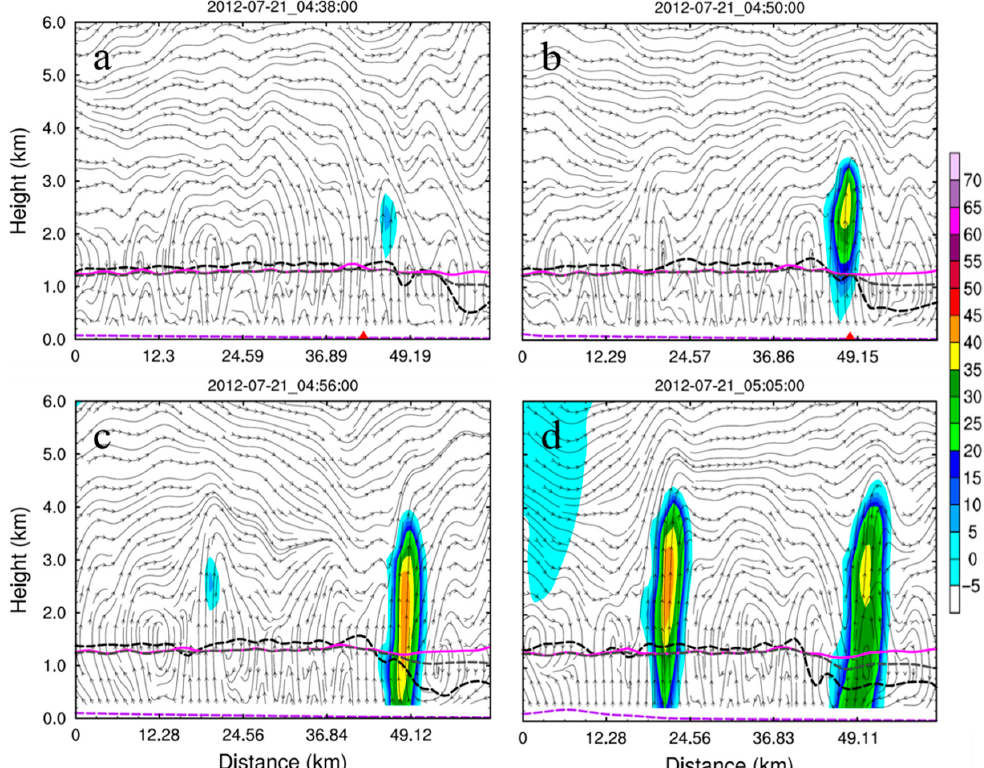
Figure 7. ( a – d ) Vertical cross sections of the simulated composite radar reflectivity (shaded, units: dBZ), the wind field (streamlines, units: m s − 1 ), the lifting condensation level (LCL) (gray dotted line), the planetary boundary layer height (PBLH) (black dotted line), and the level of free convection (LFC) (magenta solid line) at 0438, 0450, 0456, and 0505 UTC 21 July 2012, respectively. The locations of cross sections were denoted by the magenta lines given in Figure 6.